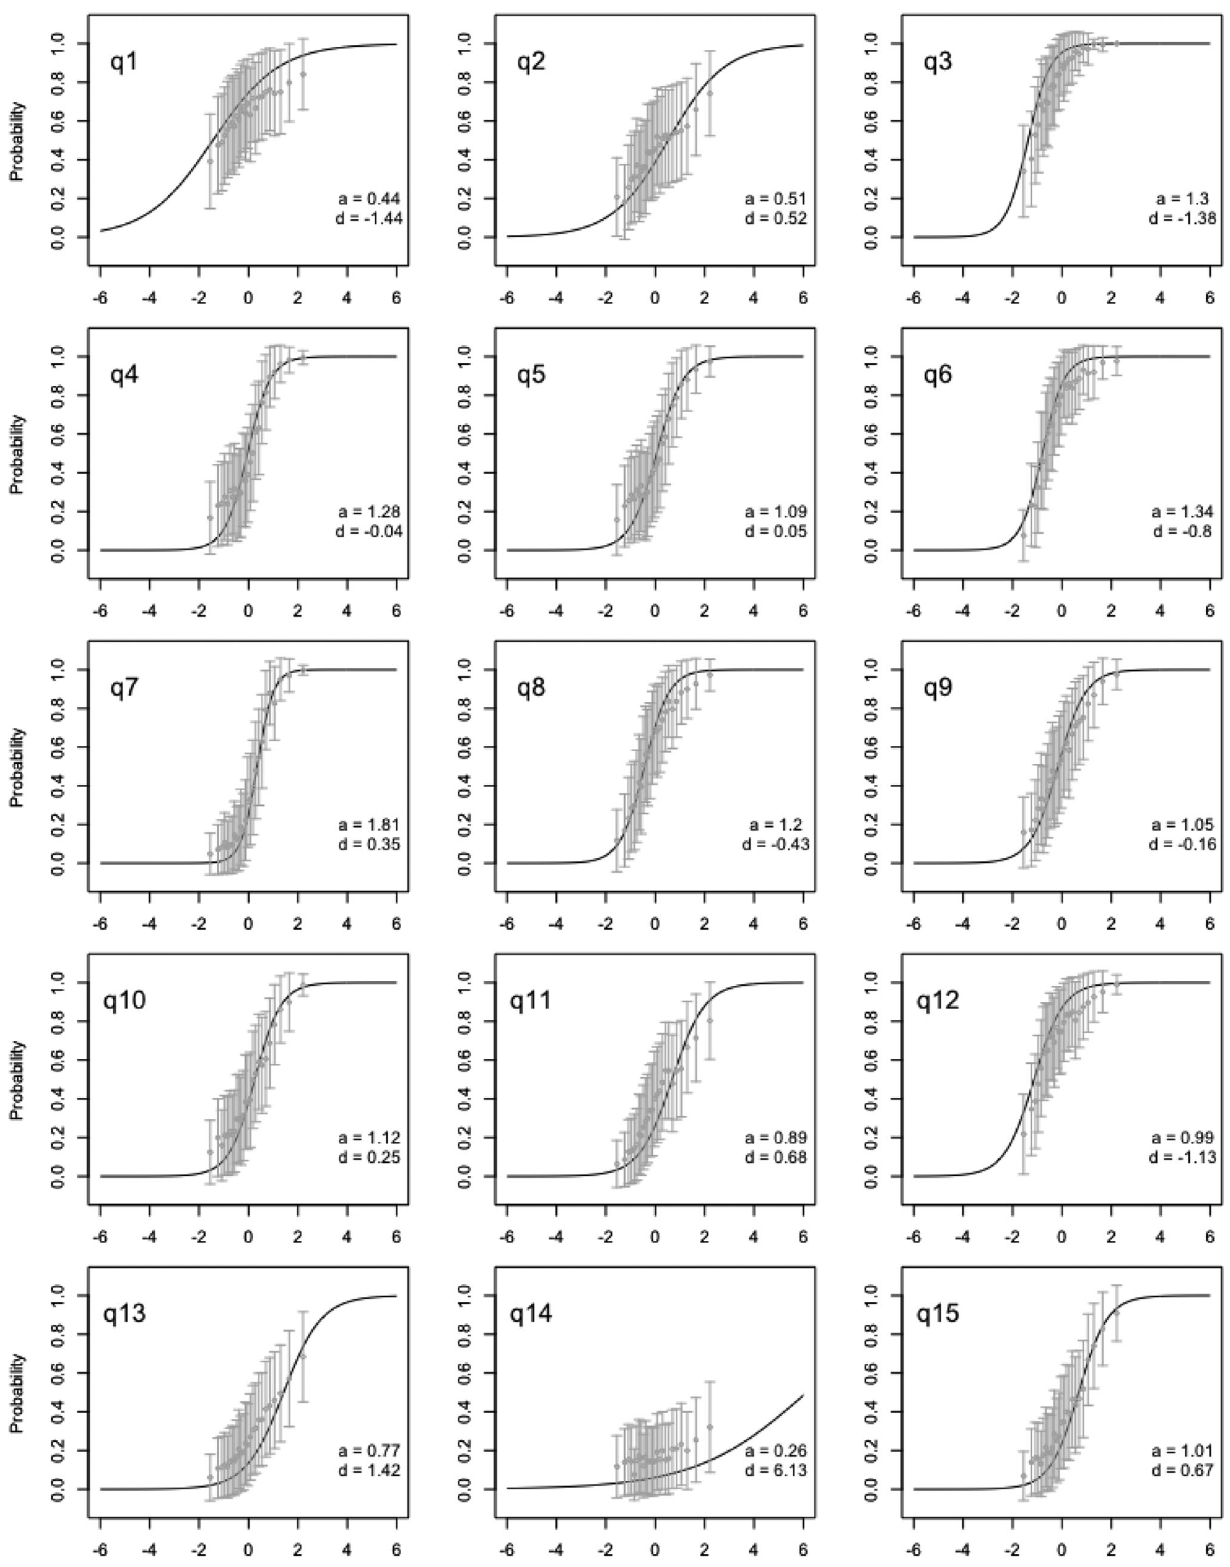
FIG. 13. Item characteristic curves for the item 1 – 15 on the CSEM. The gray error bars represent one standard deviation, from top to bottom, in the student responses. The horizontal axis is student latent